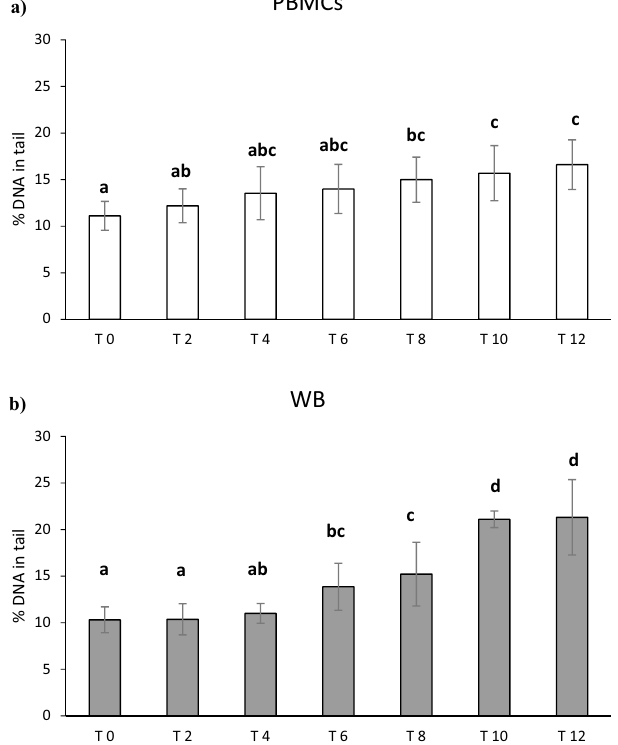
Figure 2. Effect of long-term cryopreservation on Fpg-sensitive sites in PBMCs ( a ) and WB ( b ). T0 refers to fresh samples that have been processed in the comet assay without cryopreservation. T2-T12 are samples that have been cryopreserved between 2 and 12 months. Data are reported as mean ± standard deviation (SD); PBMCs peripheral blood mononuclear cells, WB whole blood. a,b,c,d Data with different letters are significantly different ( p <